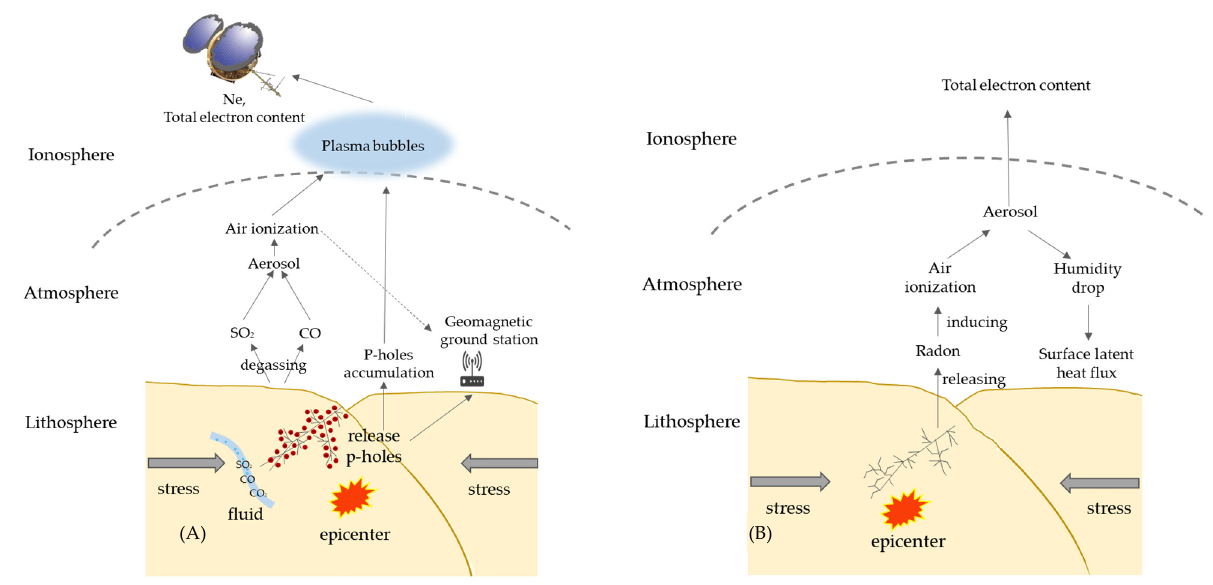
Figure 26. Graphic sketch of mechanisms. ( A ) Electromagnetic coupling driven by p ‐ holes with also possible degassing process; ( B ) Chain of lithosphere atmosphere and ionosphere coupling (chemical ‐ physical mechanisms) driven by radon release and air ionization .